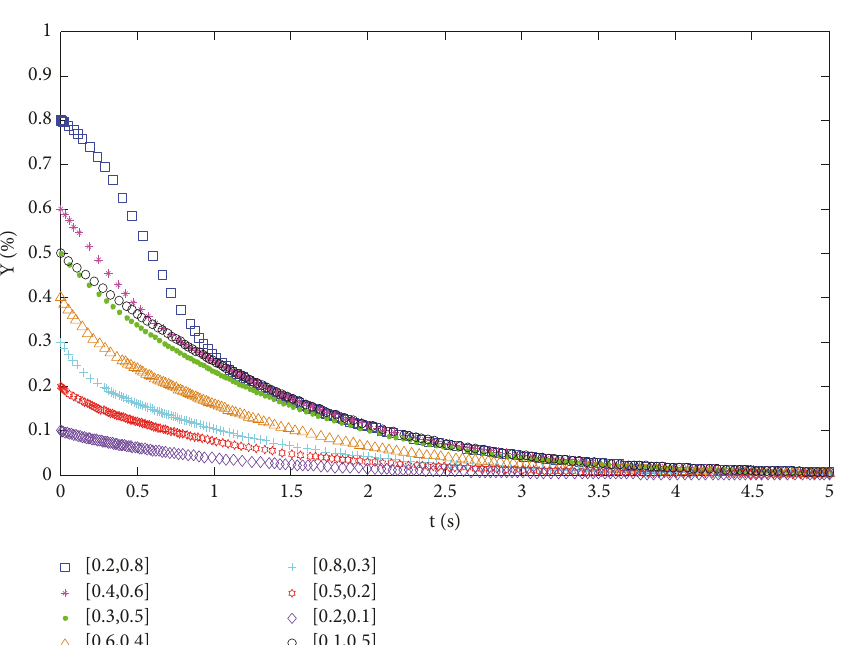
Figure 8: The X-t type of phase diagram (ESS: A(0,0)).